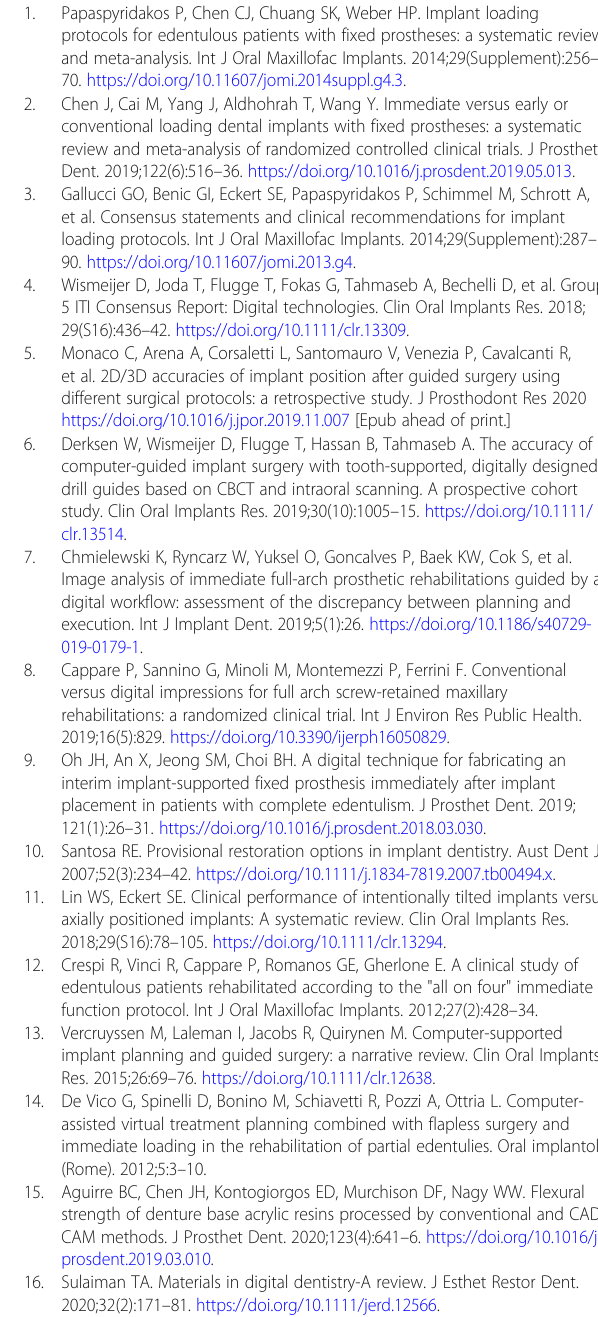
Fig. 17 Interim prosthesis in situ at 1